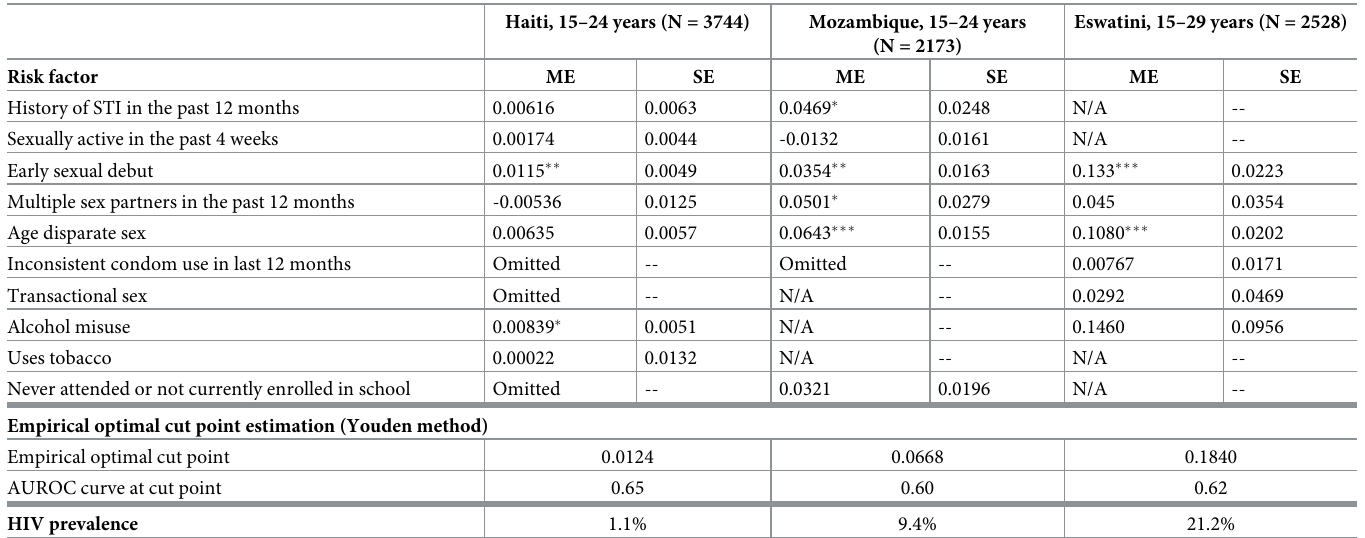
Table 4. Complimentary log-log regression